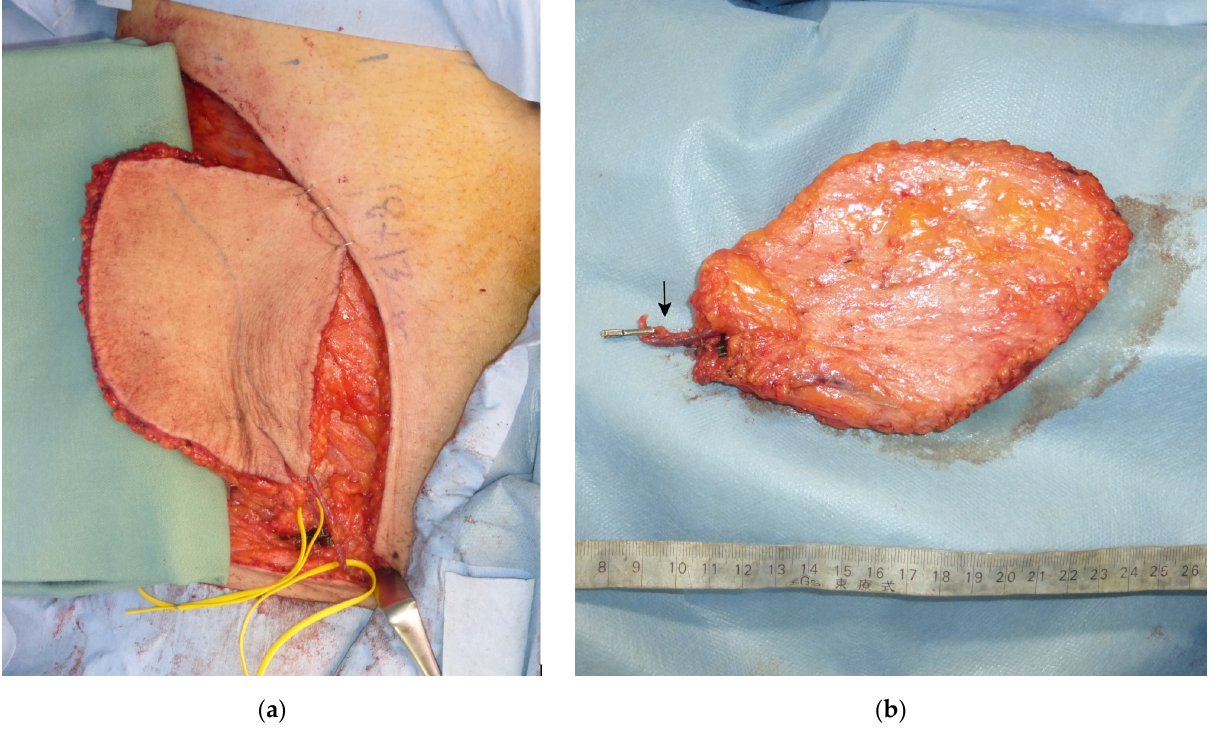
Figure 3. The SCIP flap was elevated saving the deep fat. ( a ) The deep fat remained at the donor site; ( b ) the pedicle of the flap (arrow), the superficial branch of the SCIA, was covered with the fat tissue between the superficial and Camper fasciae in the flap.